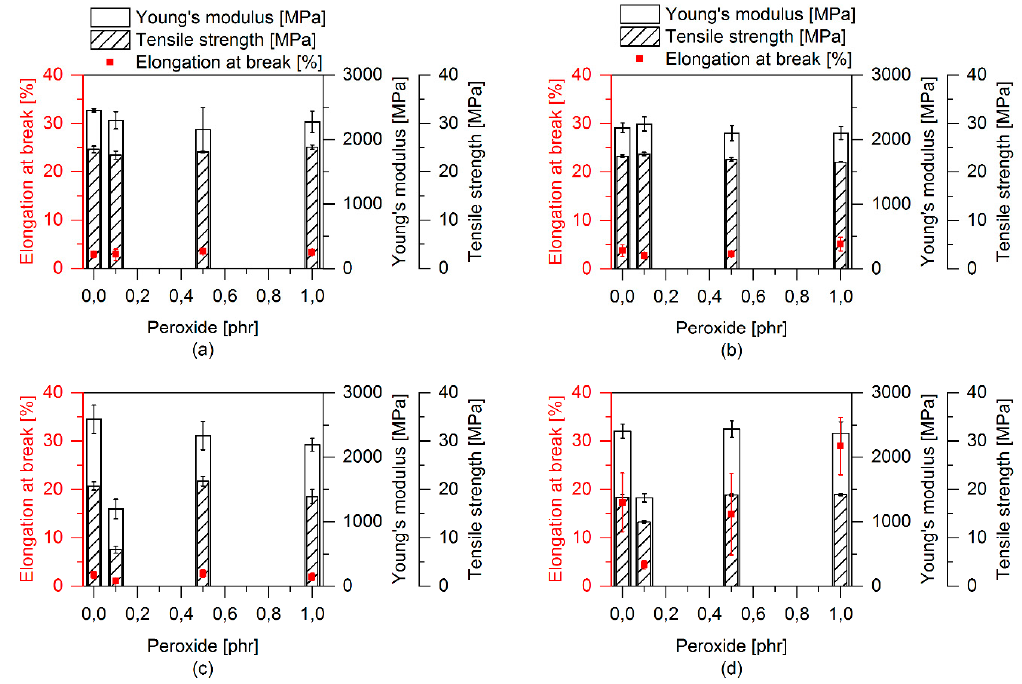
Figure 12. Tensile properties with varying TBEC content. Each sample contains 20 pph of soft phase. ( a ) Samples without SBO and EMAGMA, ( b ) samples containing 5 pph EMAGMA, ( c ) samples containing 20 wt % SBO inside the soft phase and ( d ) samples containing 5 pph EMAGMA and 20 wt % SBO inside the soft phase.